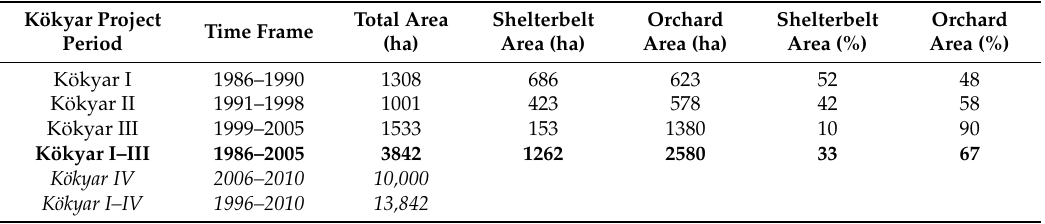
Table 1. Overview of the present four project periods of Kökyar Protection Forest. Bold numbers: sums of single project areas; italic numbers: provisional figures of the planned extent. 1.